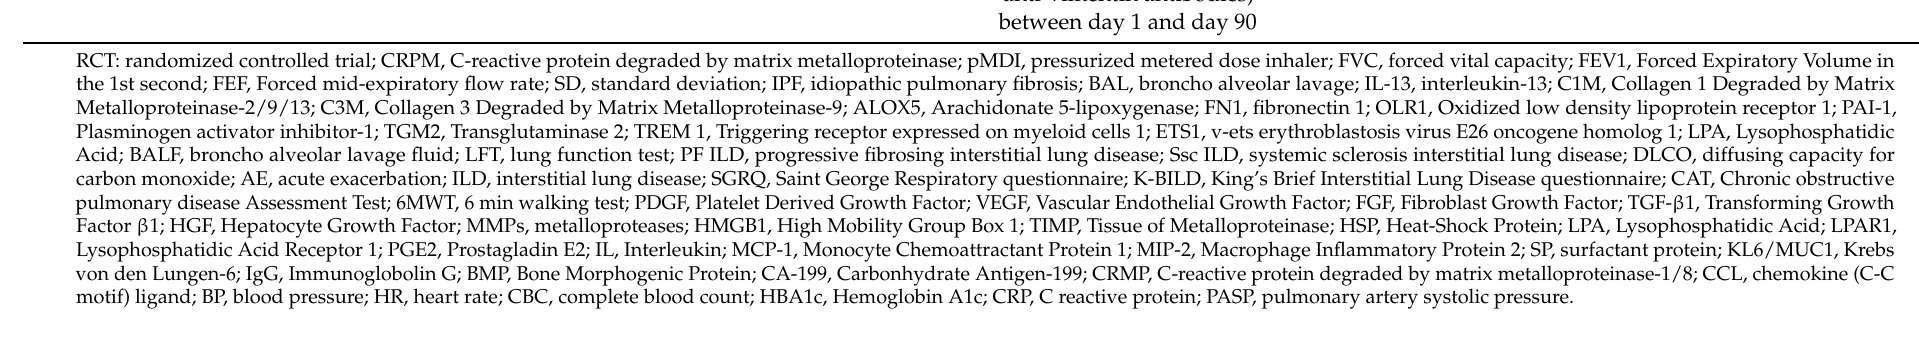
Table 4. Ongoing clinical studies on biomarkers in